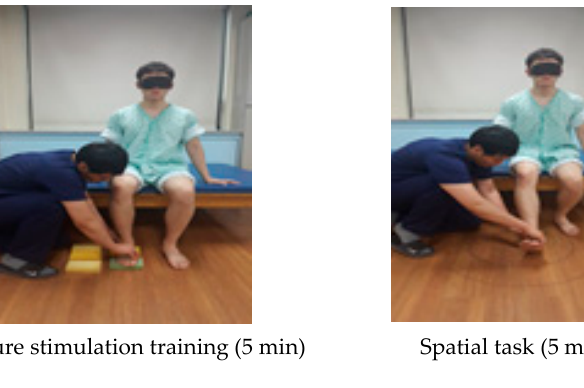
Figure 1. Cognitive sensory exercise. Table 1. Cognitive sensorimotor exercise